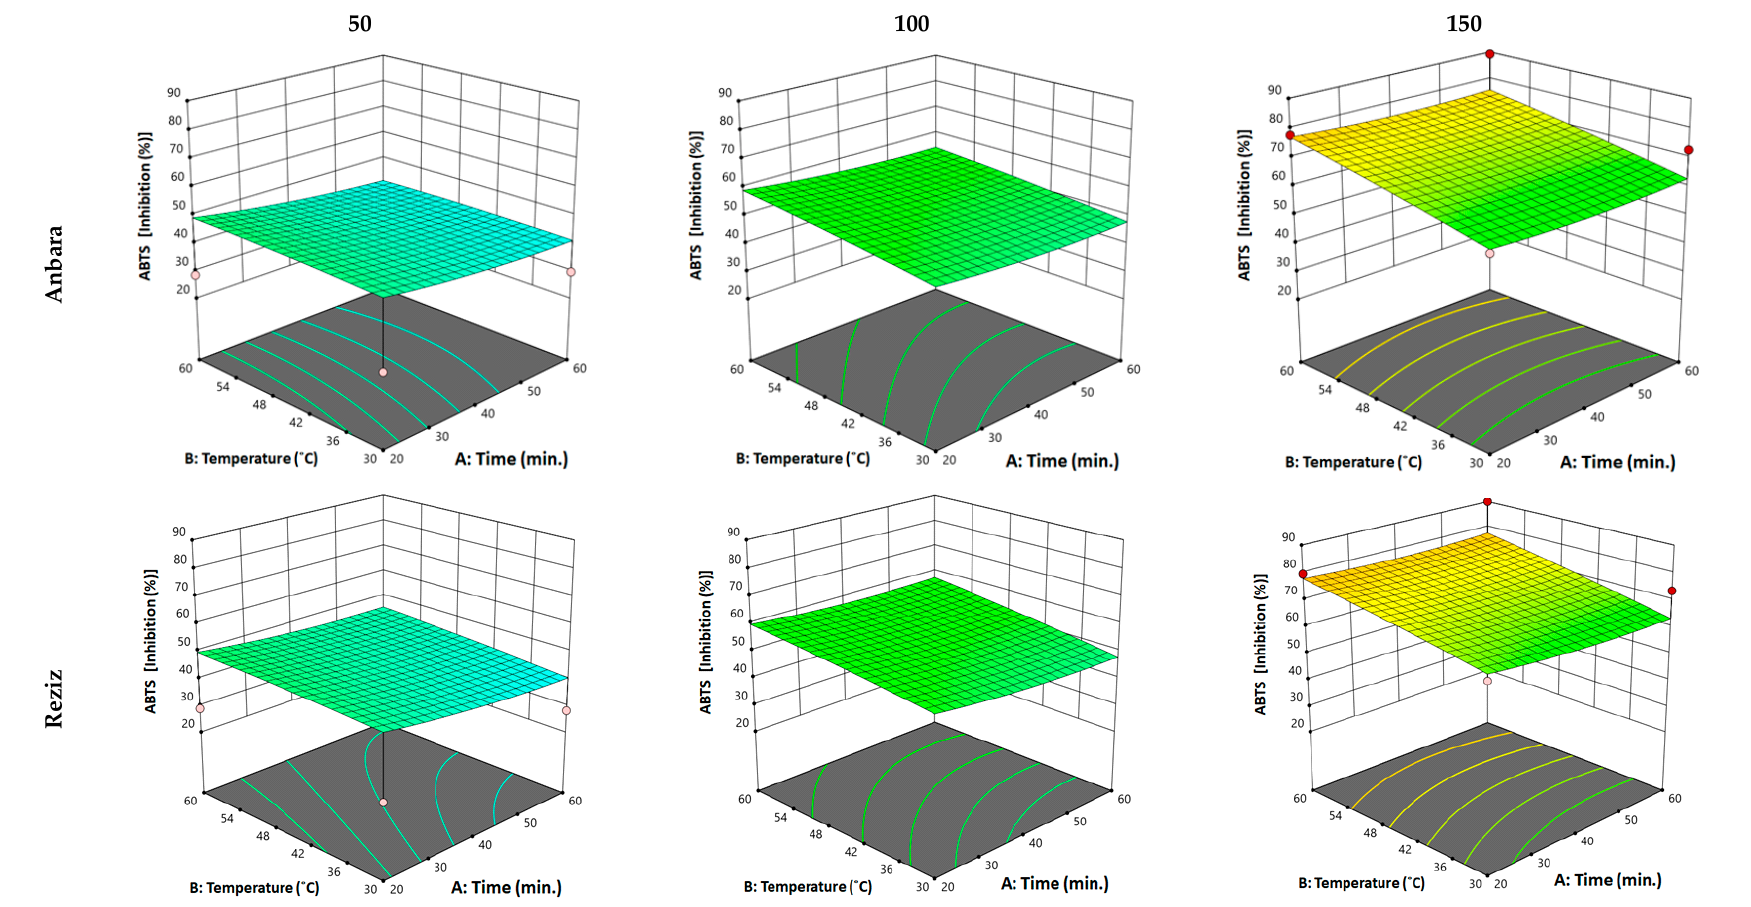
Figure 4. Three-dimensional response surface plot for the “response” variable: (radical-scavenging antioxidant ability by ABTS), as a function of WAE “factors”: temperature, time, and rotation in two date palm fruits cultivars, Anbara and Reiziz.